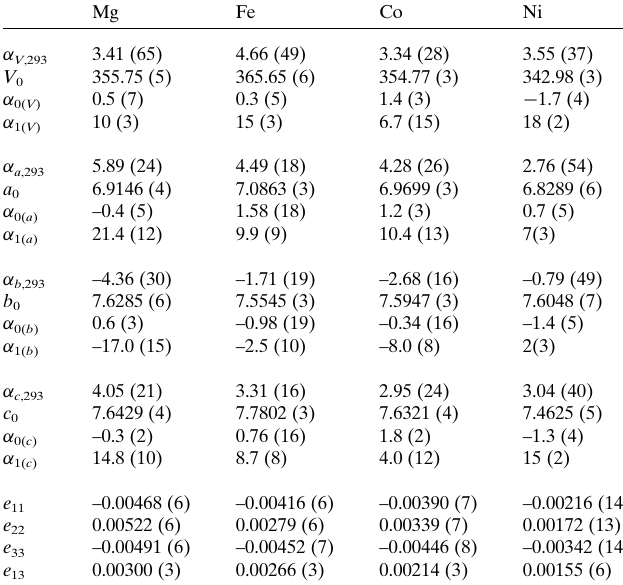
Table 1 Results of Fei-type thermal EoS and strain tensor calculations for kieserite-type compounds M 2+ SO 4 (cid:2) H 2 O ( M 2+ = Mg, Fe, Co, Ni) for T ref = 293 K using EoSFit7c (Angel et al. , 2014). Values of (cid:2) are given as (cid:2) (cid:9) 10 (cid:8) 5 K (cid:8) 1 , (cid:2) 0 (cid:9) 10 5 K (cid:8) 1 and (cid:2) 1 (cid:9) 10 8 K (cid:8) 2 . The parameter